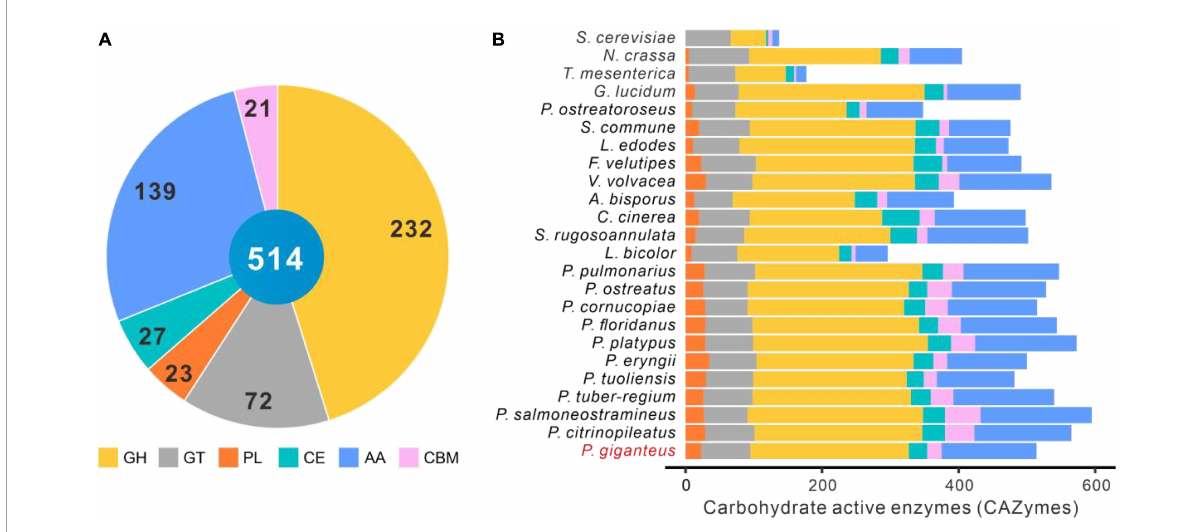
FIGURE6 Carbohydrate-active enzymes (CAZymes) in P. giganteus and other 23 fungi. (A) The distribution of CAZymes categories in P. giganteus . (B) The distribution of CAZymes in other 23 fungi. The strain names of these fungi are the same as those in Figure 3 . GH, glycoside hydrolase; GT, glycosyltransferase; PL, polysaccharide lyase; CE, carbohydrate esterase; CBM, carbohydrate-binding module; AA, auxiliary activity.